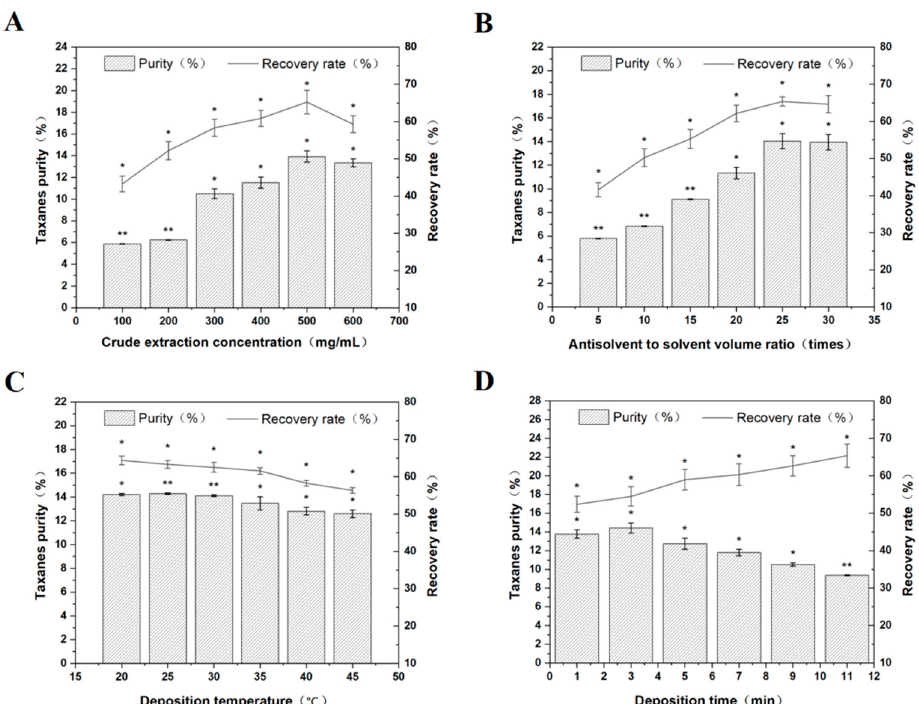
Figure 3. Effects of ( A ) the crude extraction concentration, ( B ) antisolvent to solvent volume ratio, ( C ) deposition temperature, and ( D ) deposition time on the purity of eight taxanes in Taxus cuspidata ( p < 0.05 indicated by *, p < 0.005 indicated by **).